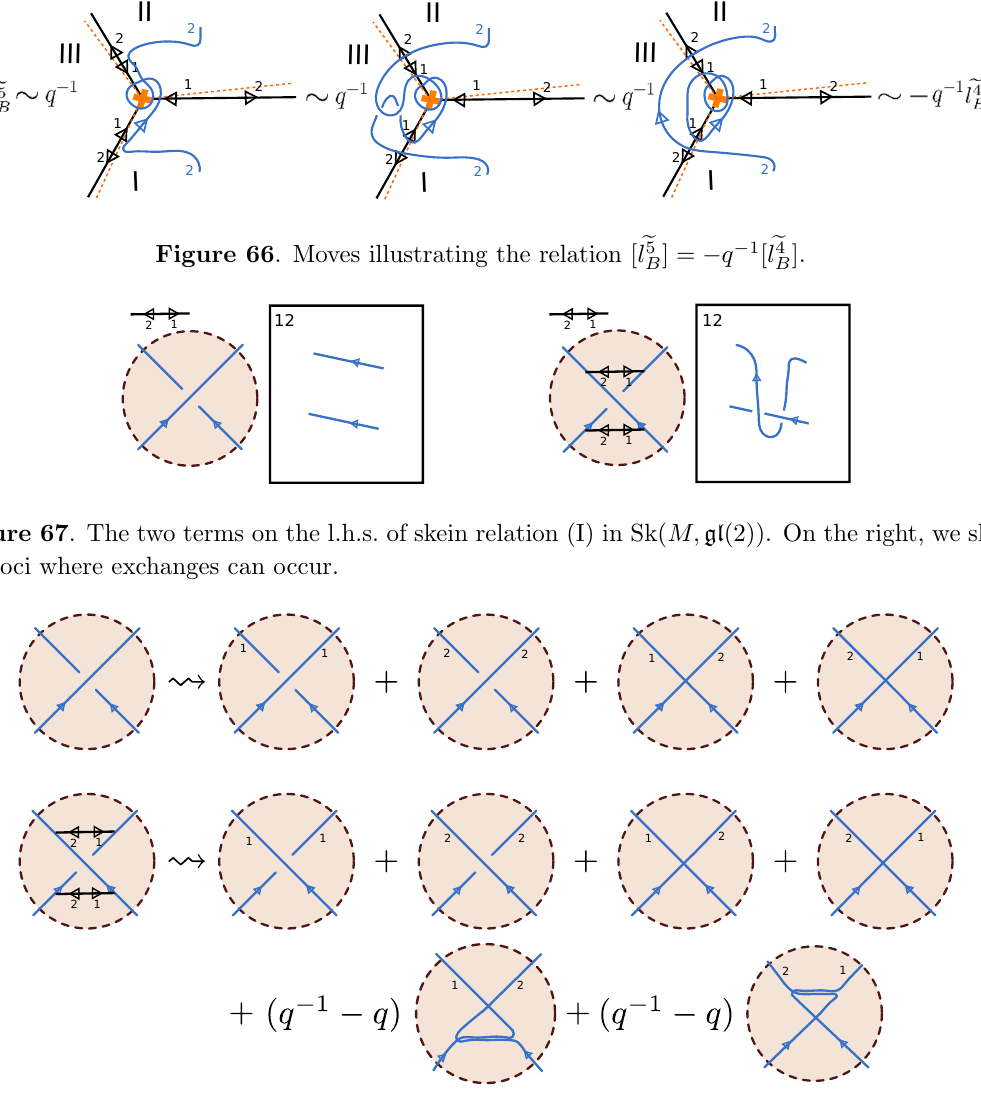
Figure 68 . Applying F to the l.h.s. of skein relation (I) in Sk( M; gl